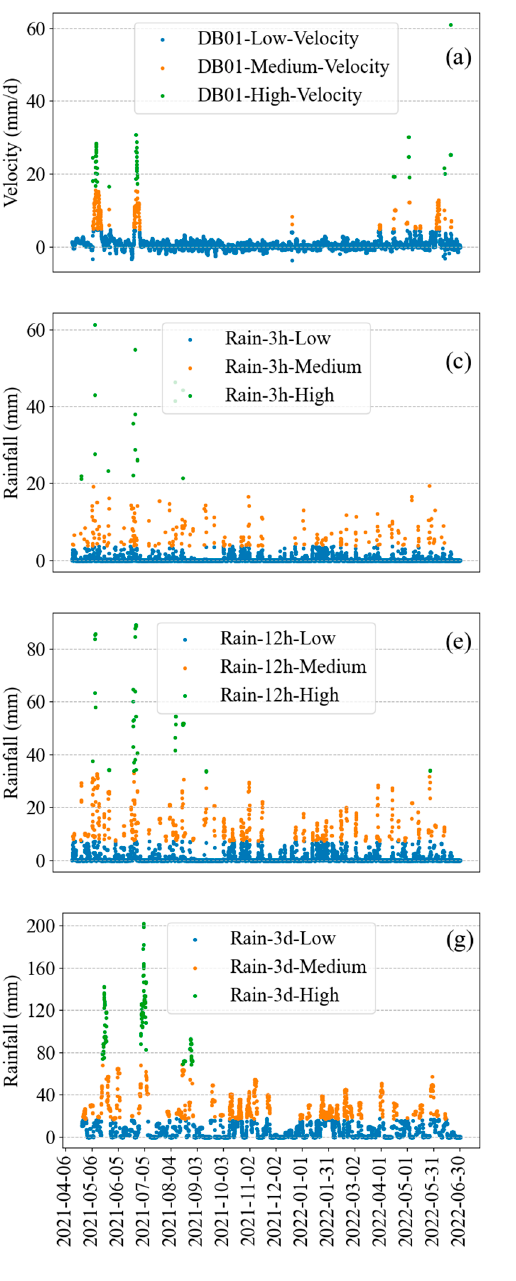
Figure 5. Visualization of all feature clustering results. ( a ) The velocity of DB01. ( b ) The velocity of DB02. ( c ) 3-h cumulative rainfall. ( d ) 6-h cumulative rainfall. ( e ) 12-h cumulative rainfall. ( f ) 24-h cumulative rainfall. ( g ) 3-day cumulative rainfall. ( h ) 7-day cumulative rainfall.